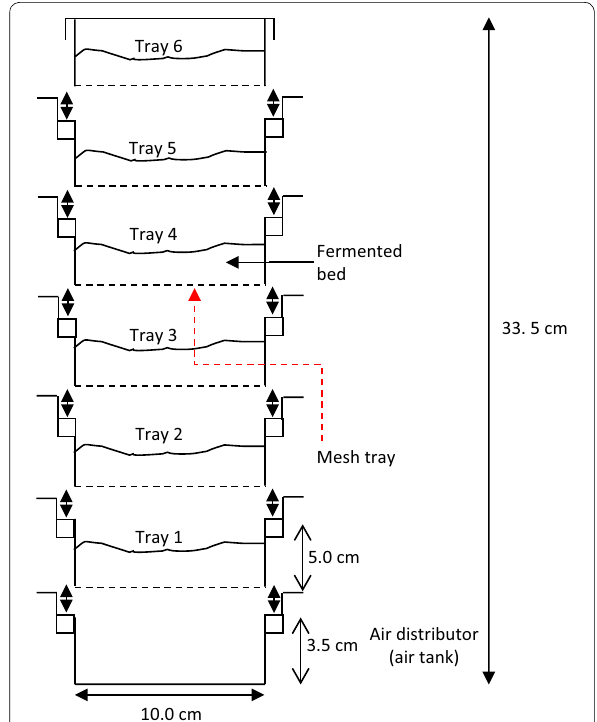
Fig. 1 A multi-stacked circular tray SSB: a perspective view of a bioreactor according to a first embodiment of the multi-stacked trays, with emphasis on the location of the seals, which are represented by the symbol “ ☐ ”, removed and a split tray installed. The tray at the bottom represents an air distributor at the bottom of the